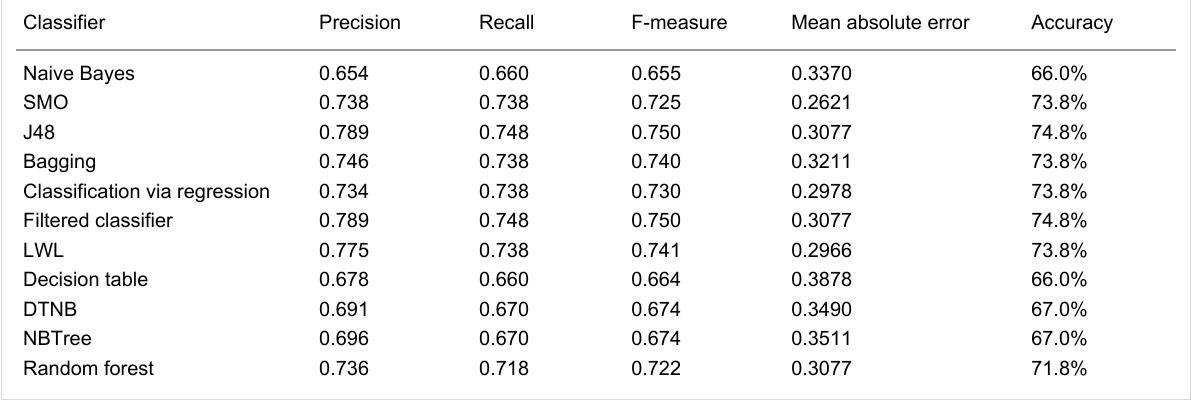
Table 1: Results from the 10-fold cross-validation listed by classifier for the first analysis including all molecular descriptors. See Equation 1–4 for the definition of precision, recall, F-measure, and mean absolute error and accuracy. Classifier